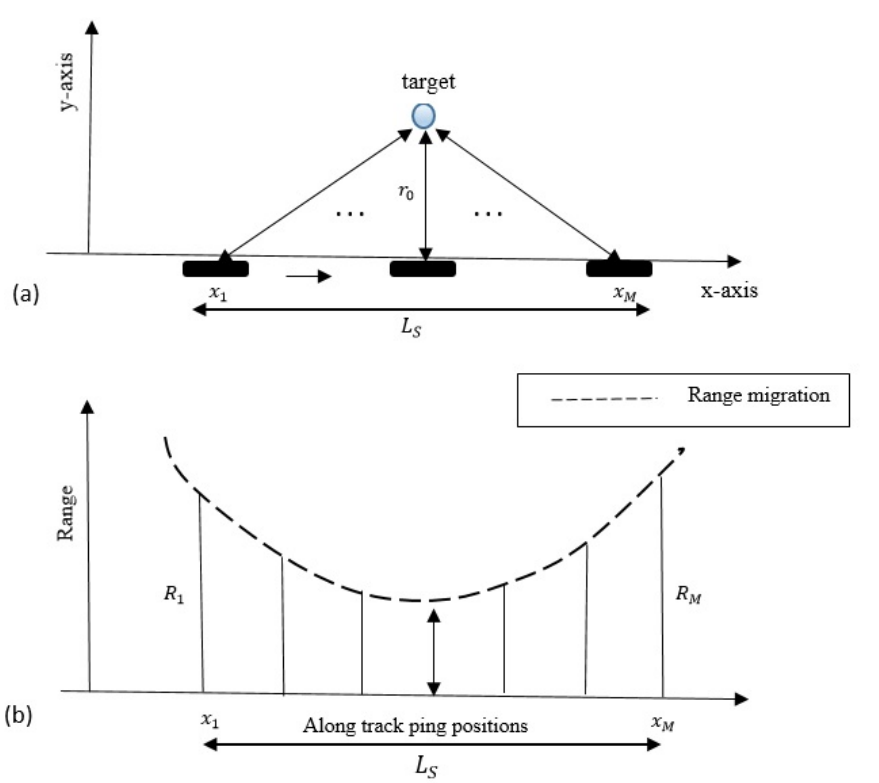
Figure 5. Range migration of the target: ( a ) The target passes through the field of view of the SAS where SAS platform moves in the along-track direction and stops at positions x m , m = 1, . . . , M; ( b ) a map of the migration of the target in the field of view of the SAS that is called range migration. r 0 is broadside range and L s is synthetic aperture length.